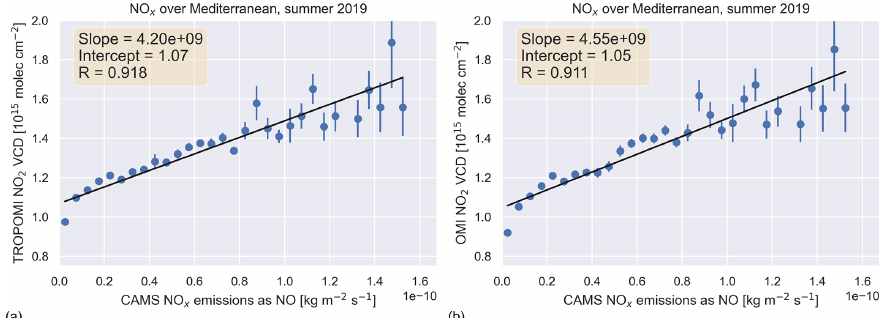
Figure C1. Scatter of binned summertime (May–September) 2019 tropospheric NO 2 columns vs. emissions from CAMS/STEAM for the same period at 0.1 ◦ × 0.1 ◦ in the Mediterranean. Error bars indicate the standard error of the bin. (a) : TROPOMI; (b) :